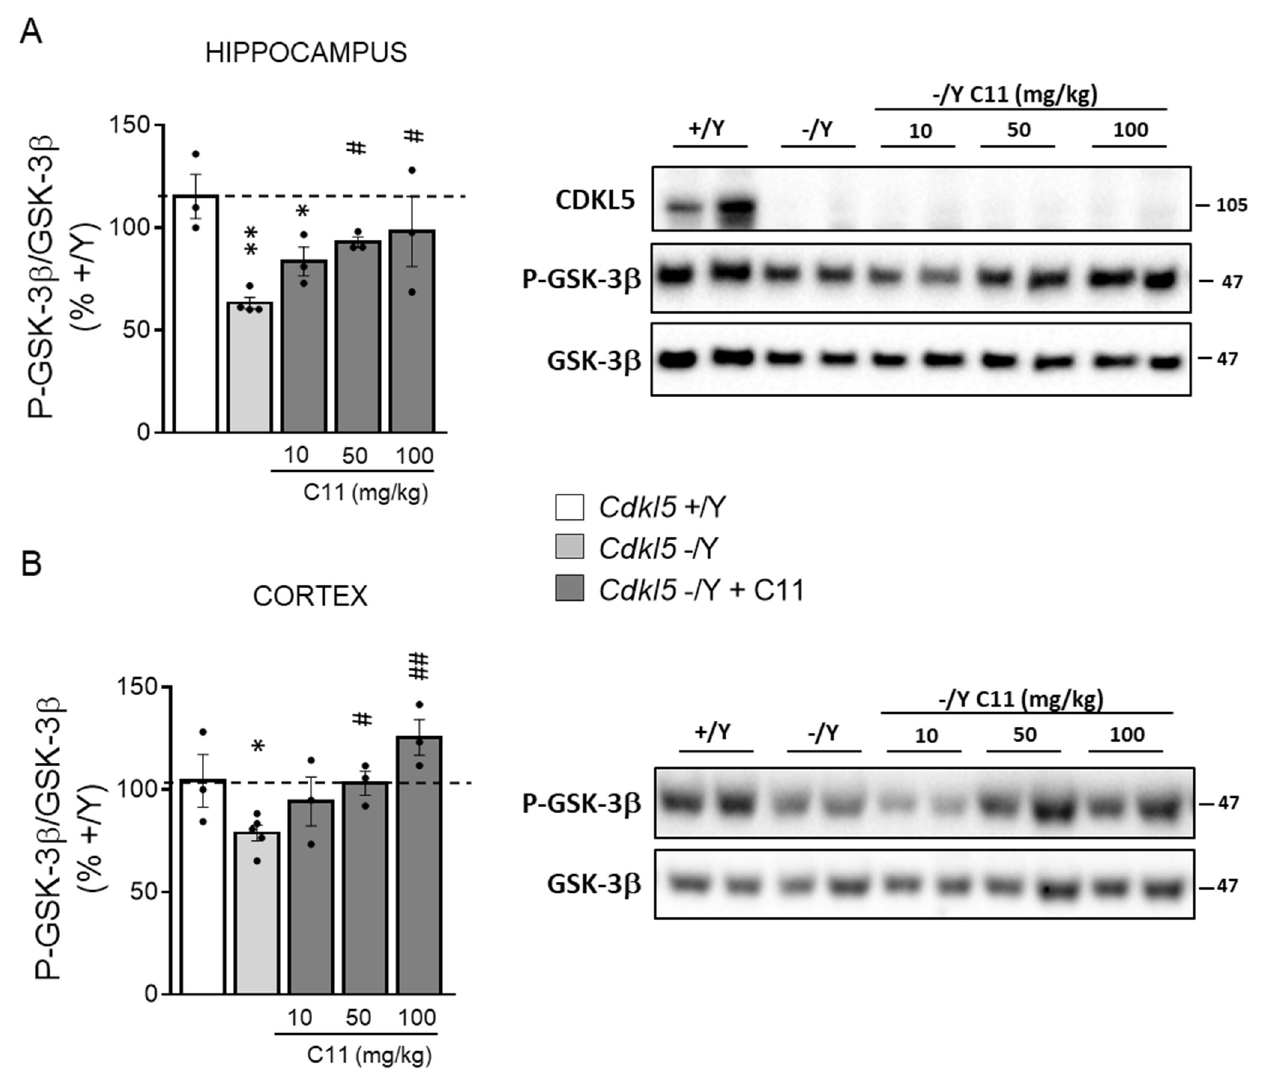
Figure 4. Effect of in vivo treatment with C11 on GSK-3 β activity in the brain of CDKL5 − /Y mice. Western blot analysis of P-GSK-3 β levels normalized to total GSK-3 β levels in the hippocampus ( A ) and cortex ( B ) of wild-type ( Cdkl5 +/Y n = 3), KO ( Cdkl5 − /Y n = 4–5), and KO treated with a single intraperitoneal dose of C11 ( Cdkl5 − /Y + C11 10 mg/kg n = 3, 50 mg/kg n = 3, 100 mg/kg n = 3) mice. Mice were sacrificed 4 h after the treatment. Histograms on the left show P-GSK3 β protein levels normalized to corresponding total protein levels. Immunoblots on the right are examples from two animals of each experimental group of CDKL5, P-GSK-3 β , and total GSK-3 β levels. Values are represented as means ± SE and data are expressed as a percentage of untreated Cdkl5 +/Y mice. * p < 0.05; ** p < 0.01 as compared to the untreated Cdkl5 +/Y condition; # p < 0.05; ## p < 0.01 as compared to the untreated Cdkl5 − /Y condition (Fisher’s LSD test after one-way ANOVA).